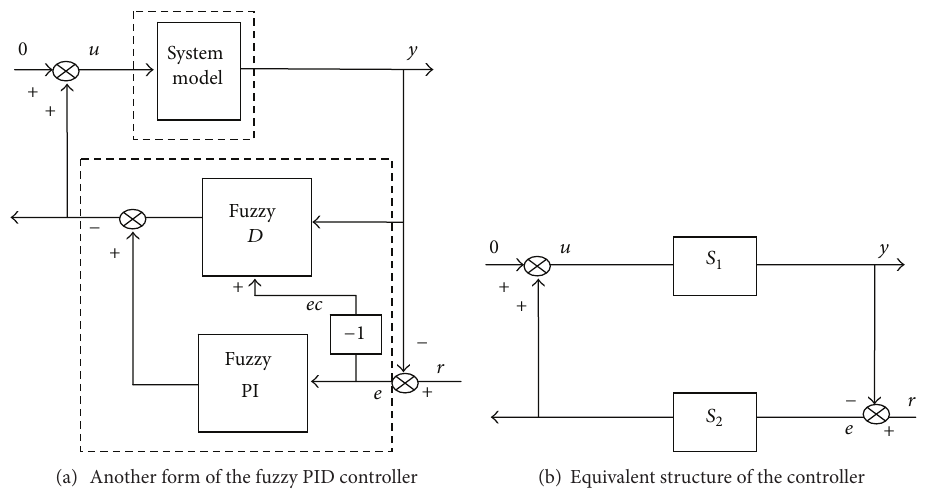
Figure 5: Equivalent closed-loop control system for the fuzzy PID controller.